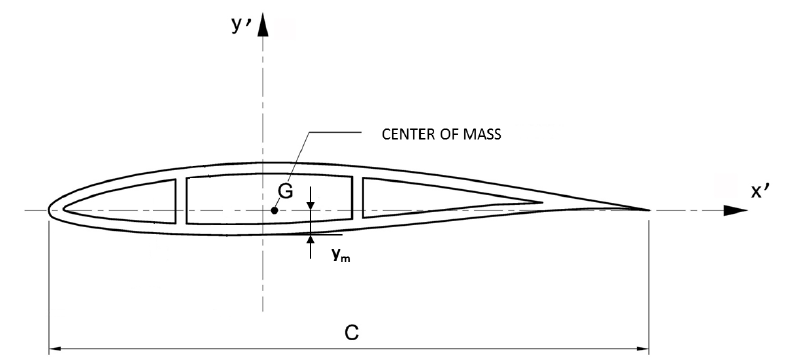
Figure 5. Blade structural